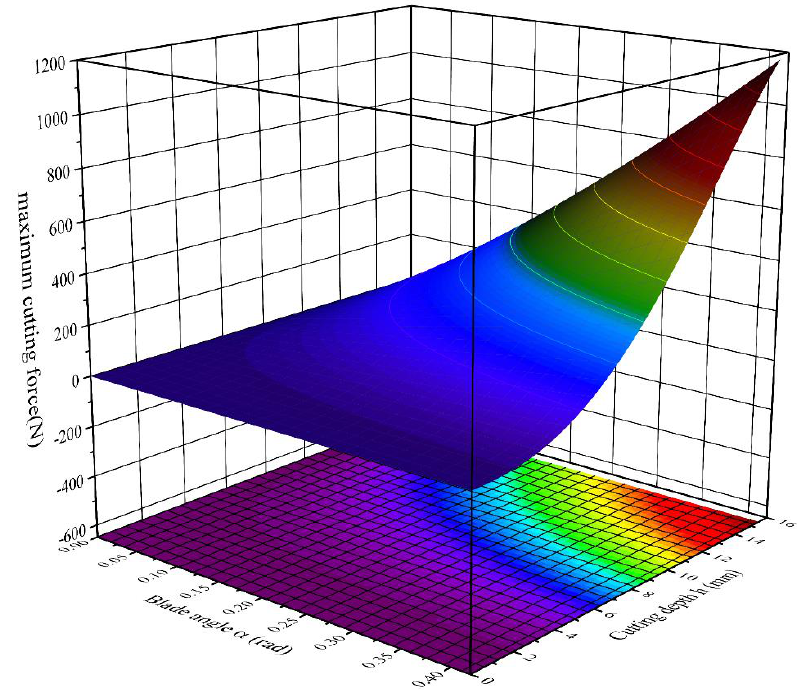
Figure 7. Reaction force theory analysis model.